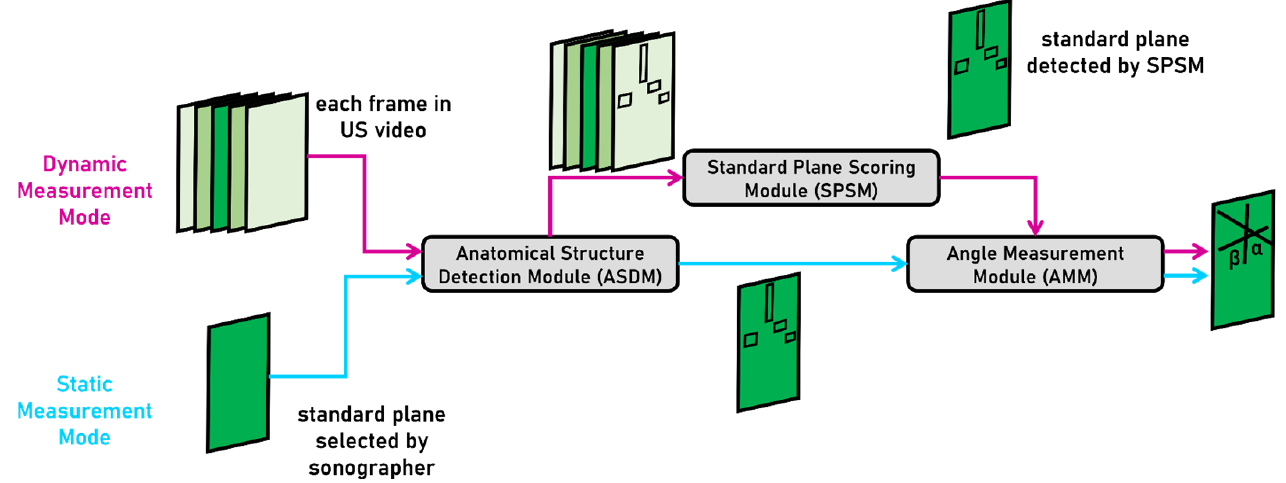
Figure 2. Overview of the proposed framework architecture. The upper route with purple marks is the workflow of DM mode and the lower route with blue marks is the workflow of SM mode.